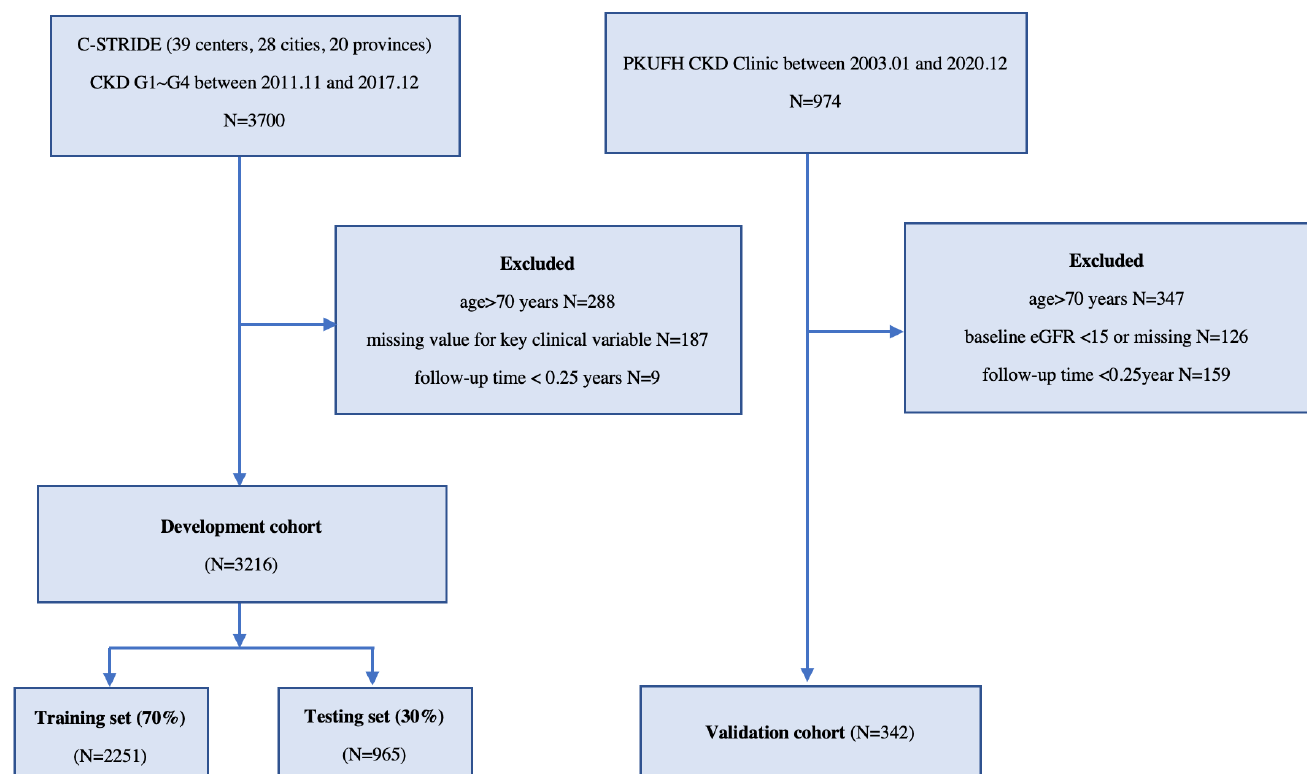
Figure 1. Flow chart of the screening and splitting of the study data. Abbreviations: C-STRIDE, Chinese cohort study of chronic kidney disease; PKUFH, Peking University First Hospital; CKD G1~G4, chronic kidney disease stages 1 – 4; N , sample number; eGFR, estimated glomerular filtration rate (mL/min/1.73 m 2 ).